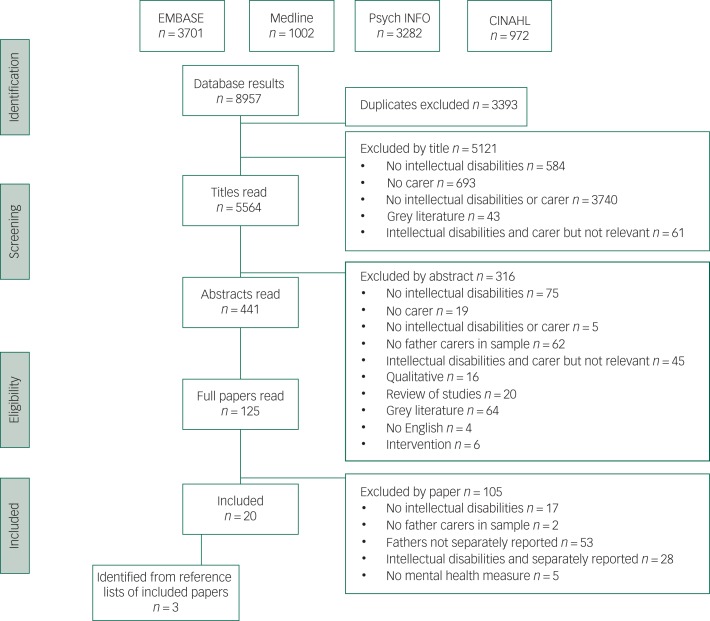
PRISMA flow diagram